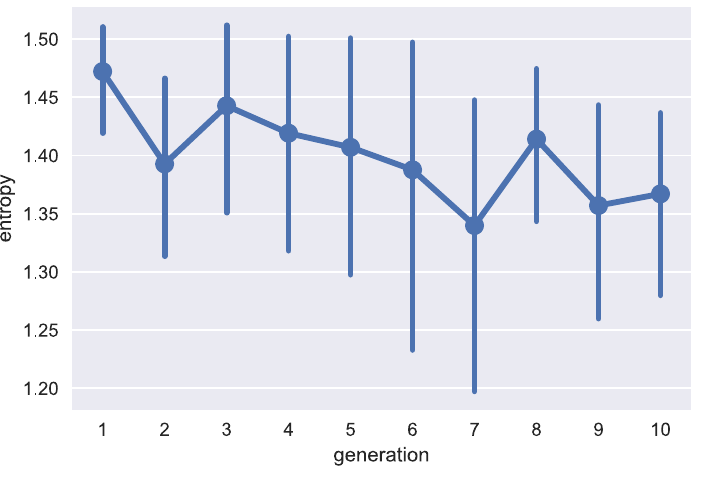
Figure 5 : The entropy of the output language produced by participants in testing over generations in bits. Bootstrapped 95% confidence intervals are shown. The input language at the start of every chain has the maximum possible entropy of 1.58 bits (with each of three noun class markers used for exactly 8 nouns). The maximum entropy for a language with 2 classes would be 1 bit. Although there appears visually to be a slight downward trend, this is not significant: counter to expectation, the languages do not become structurally simpler over